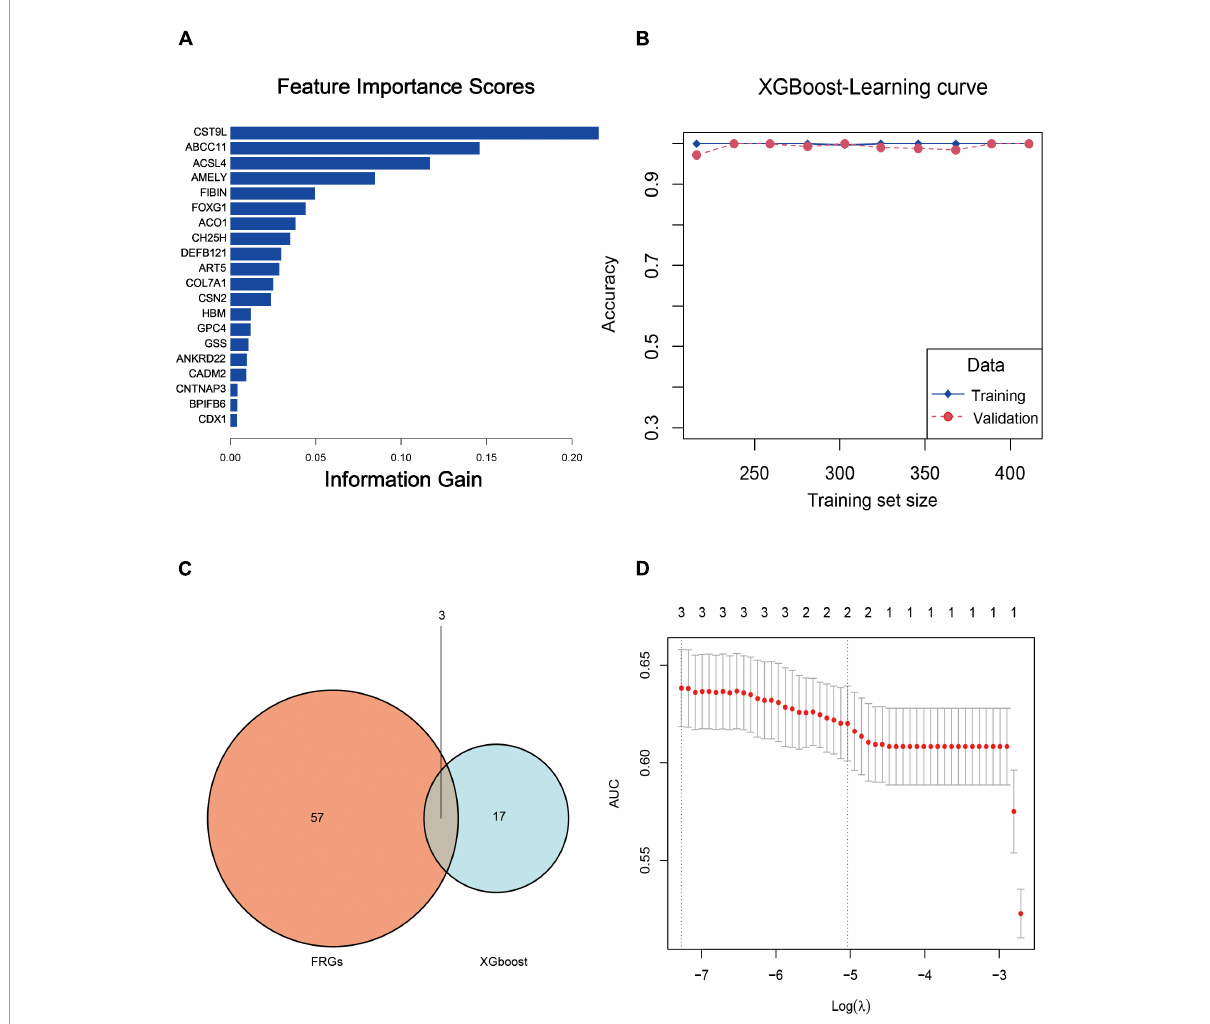
FIGURE10 (A) Feature importance rankings for the top 20 genes identified by the XGBoost model. (B) Accuracy rates in the training and validating processes upon the learning curve. (C) Venn diagram of the top 20 genes and FRGs. After cross-matching 20 XGBoost genes and 60 FRGs, we identified three crucial FRGs related to PTSD development, which were ACSL4, ACO1, and GSS. (D) LASSO coefficient profile plot of the three crucial FRGs plotted against the log (lambda)